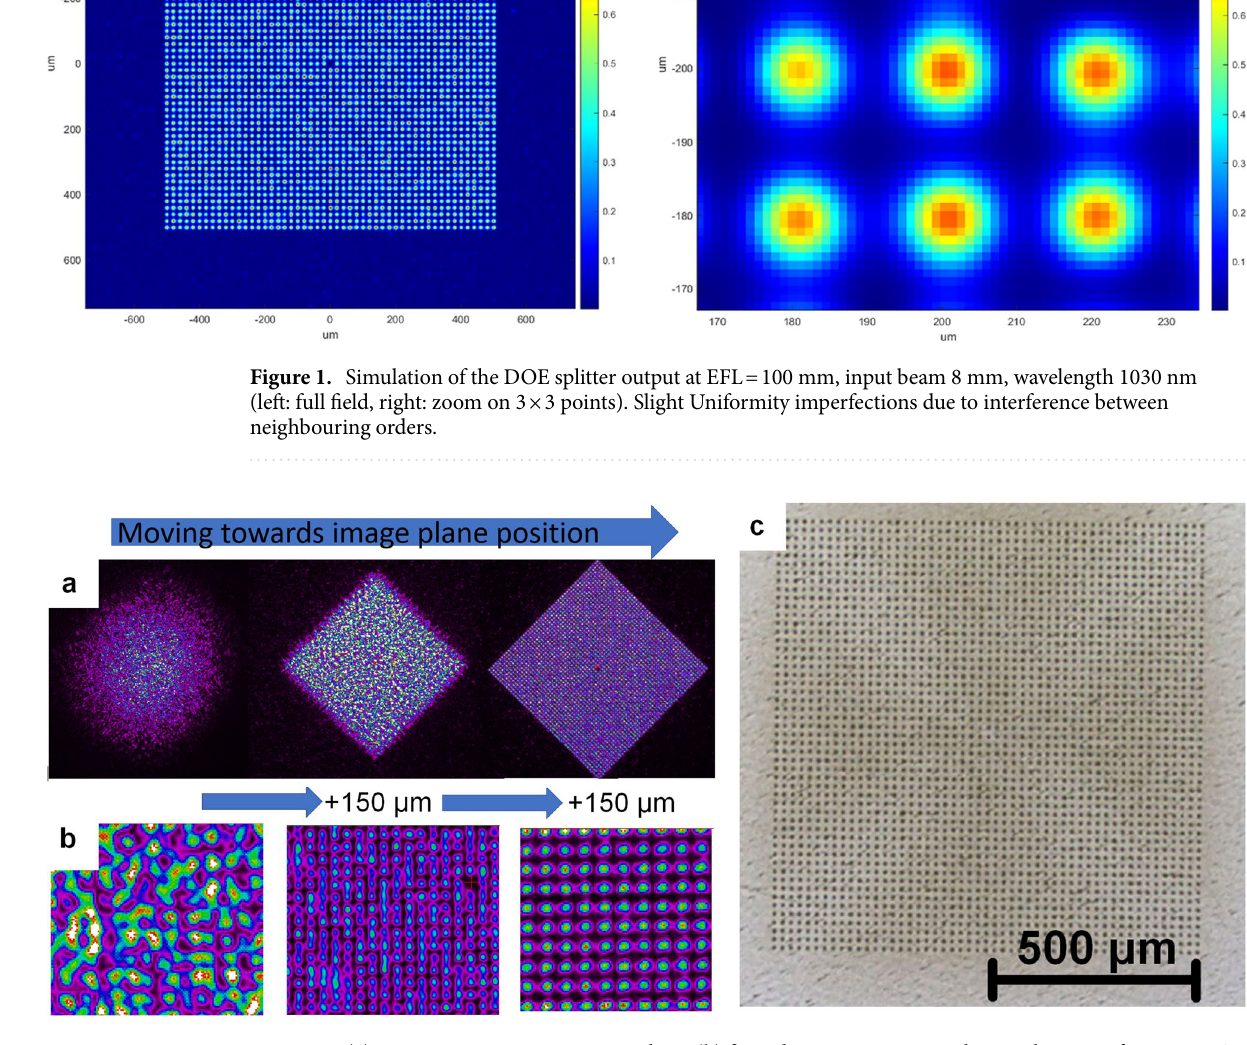
Figure 2. ( a ) coarse movement into image plane; ( b ) fine adjustment in image plane with a step of 150 µm in Z; ( c ) final pattern on stainless steel